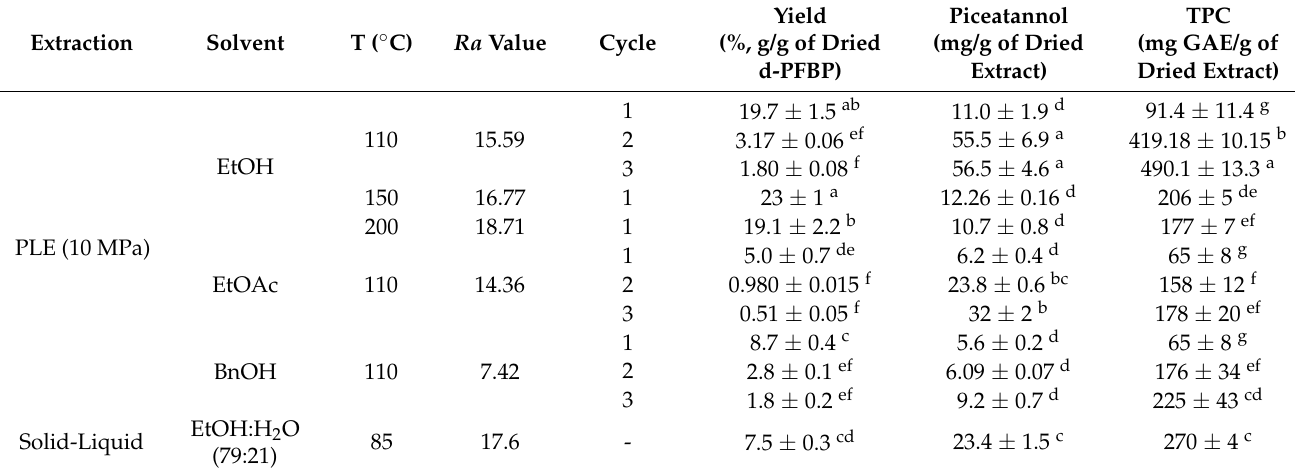
Table 3. d-PFBP extracts characterization in multi-cycle PLE and higher temperatures using different bio-solvents.